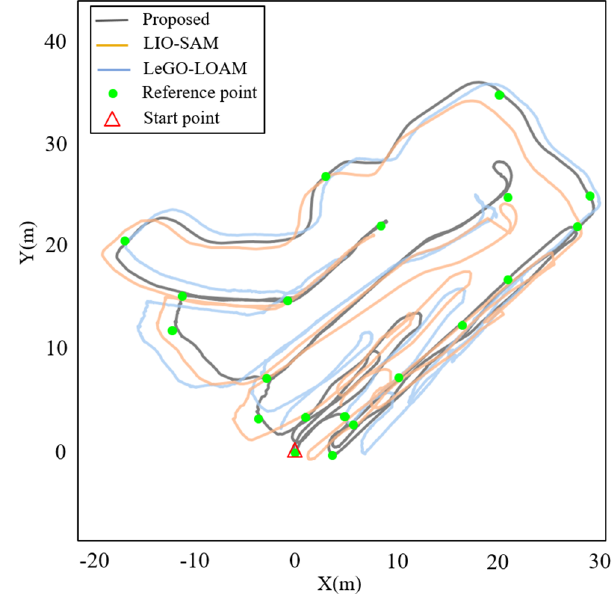
Figure 8. Comparison of the trajectories between the proposed method, LeGO-LOAM and LIO-SAM.